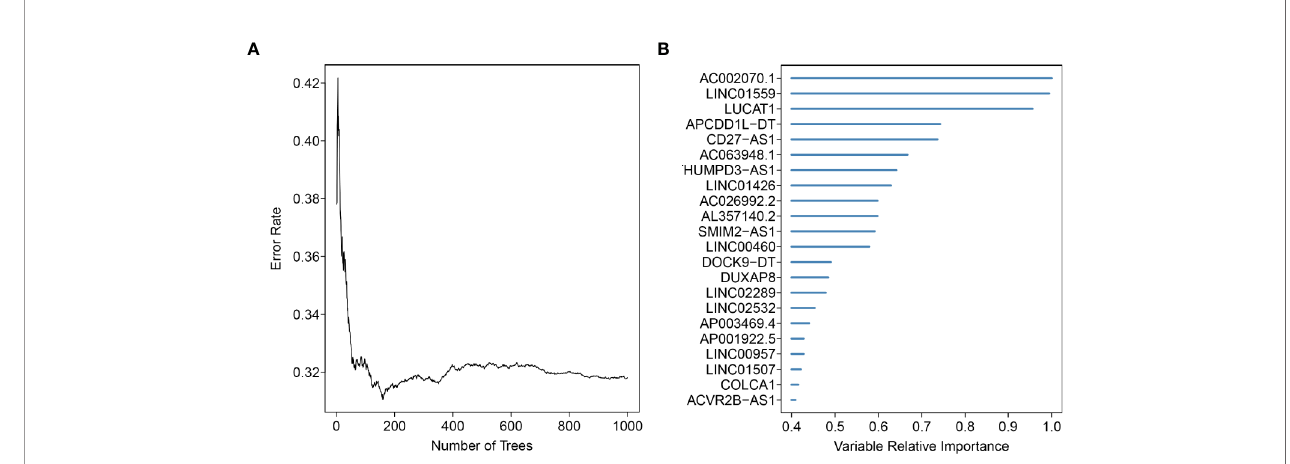
FIGURE 1 | Random forest analysis for the gene selection. (A) The association between error rate distribution and number of trees. (B) Out-of-bag importance values for the genes based on the screening